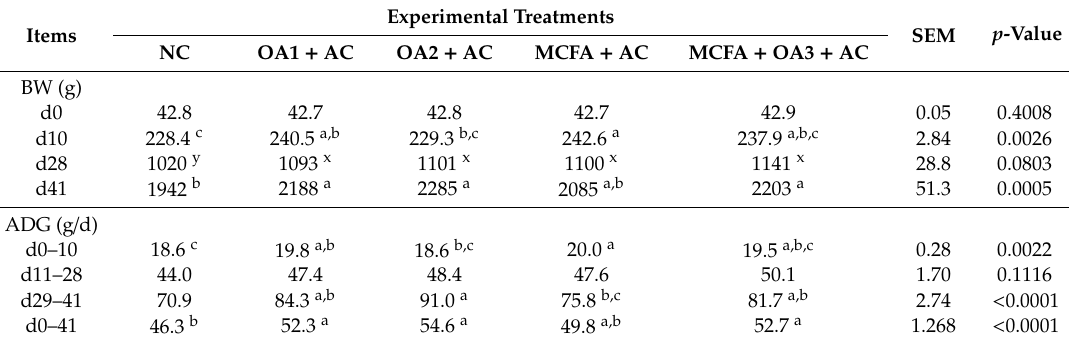
Table 2. Growth performance of chickens fed with experimental diets from d 1 to 41 (Trial